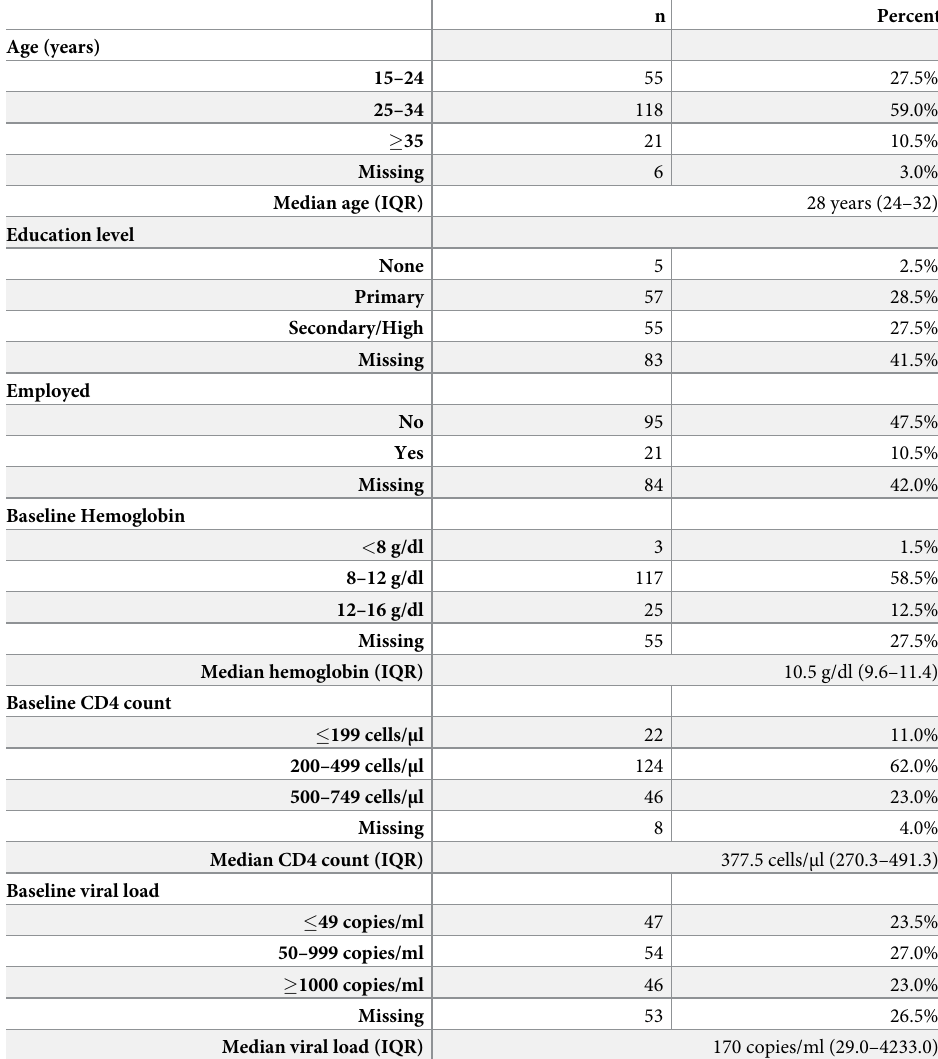
Table 1. Baseline patient characteristics (N =